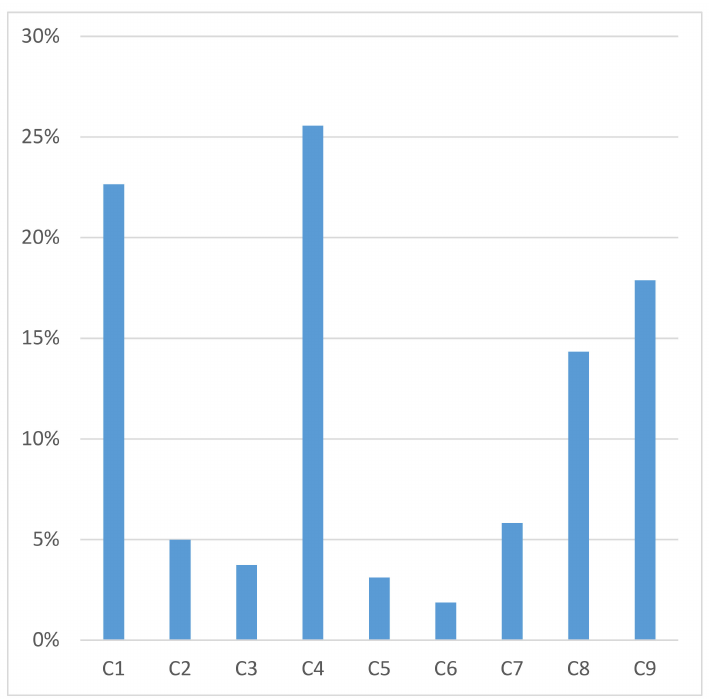
Figure 8. Requirement Category Ranking in